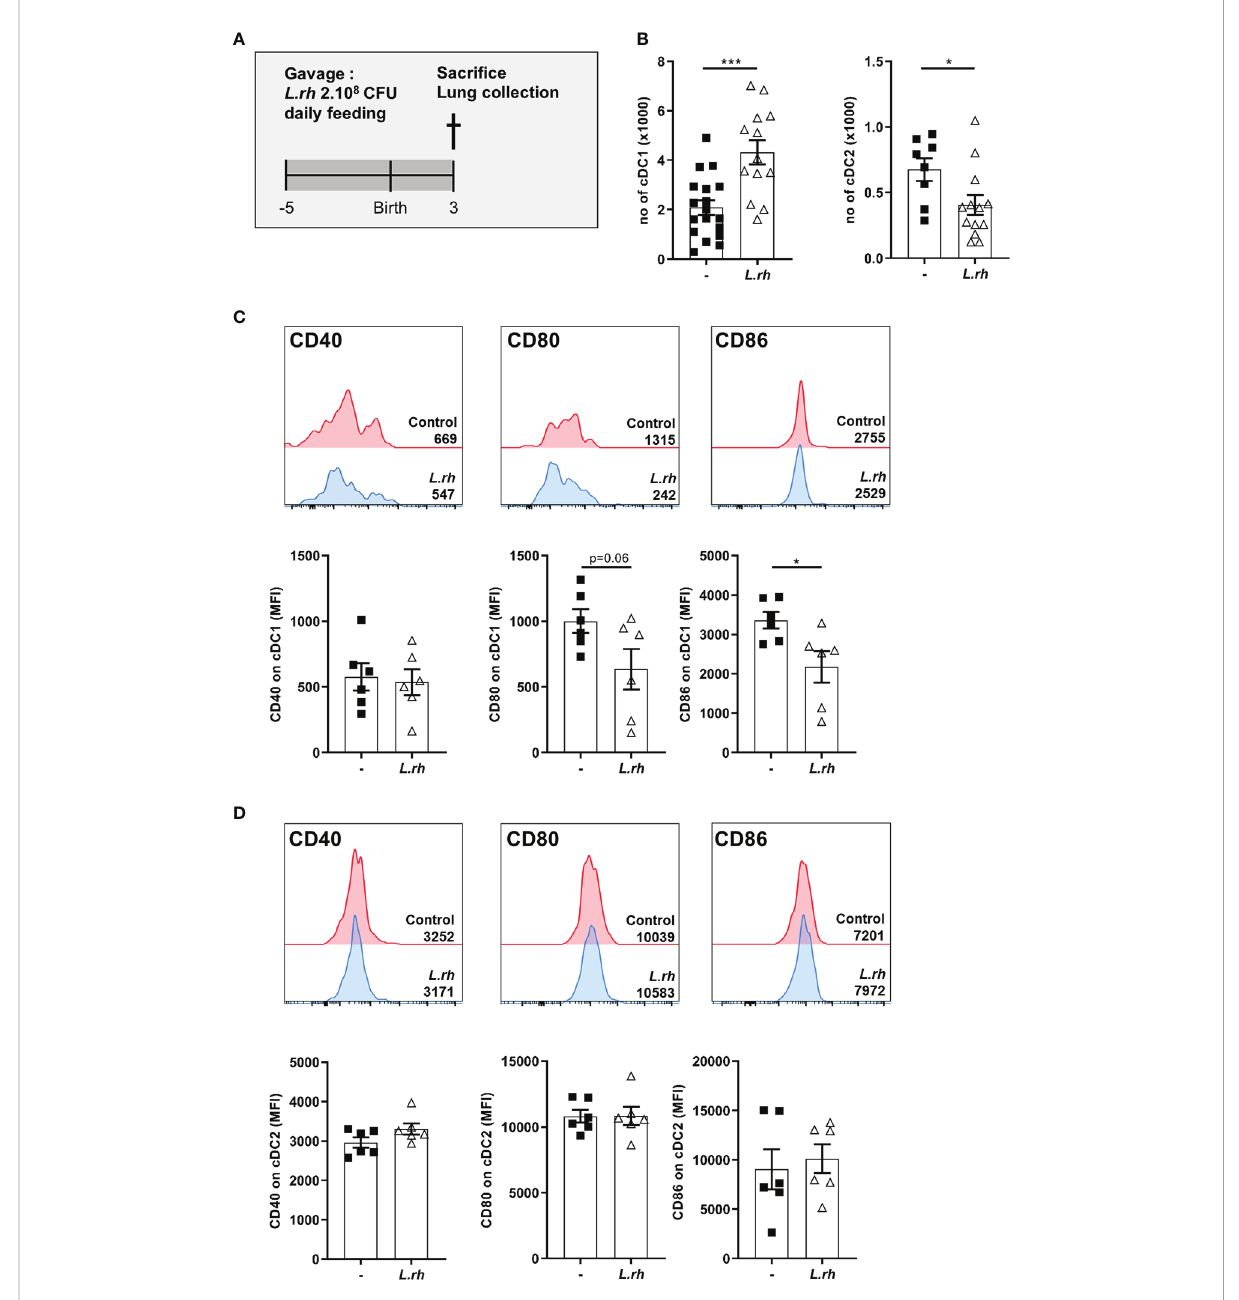
FIGURE 4 In fl uence of maternal L.rhamnosus supplementation on dendritic cell subsets in the neonatal lung. (A) Pregnant females were orally administered daily with 2.10 8 CFU of Lactobacillus rhamnosus VES001 from 5 days before to 3 days after delivery. The lungs of PND3 neonates born from control (-) or L.rhamnosus -treated ( L.rh ) mothers were collected, digested and stained for FACS analysis. (B) Total number of cDC1 and cDC2, de fi ned as CD45 + F4/80 - CD64 - CD11c + MHCII + CD26 + XCR1 + SIRPa - and CD45 + F4/80 - CD64 - CD11c + MHCII + CD26 + XCR1 - SIRPa + cells respectively. (C, D) Representative single histograms and MFI of CD40, CD80 and CD86 markers in cDC1 (C) and cDC2 (D) gated population. The MFI of representative samples are shown on the single histograms. Results are a pool of 2 – 3 independent experiments and are shown as mean ± SEM. Statistical analysis was done using an unpaired t test or a Mann-Whitney test. (* = p<0.05; *** =